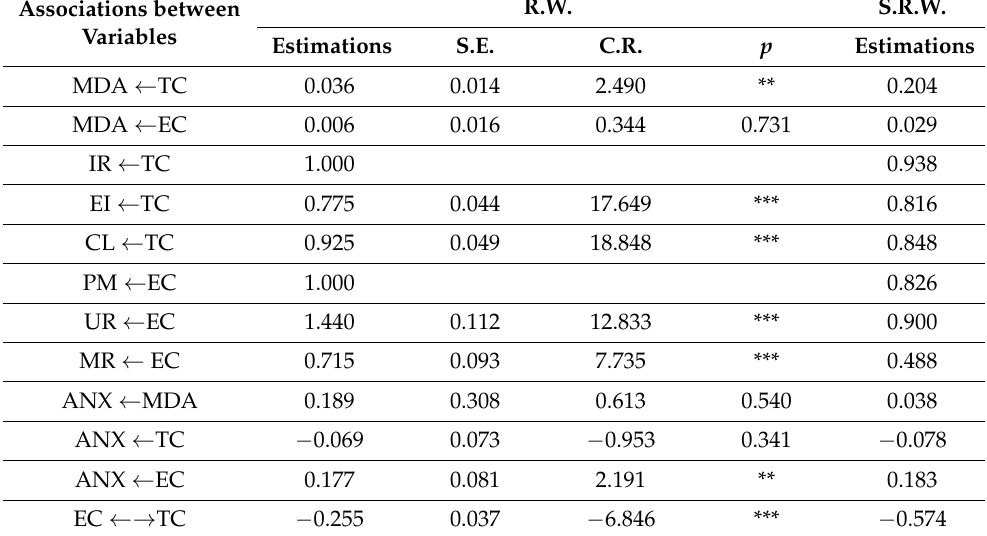
Table 4. Structural model for participants showing a high level of weekly PA. R.W. S.R.W. Associations between Variables Estimations S.E. C.R. p Estimations MDA ← TC 0.036 0.014 2.490 ** 0.204 MDA ← EC 0.006 0.016 0.344 0.731